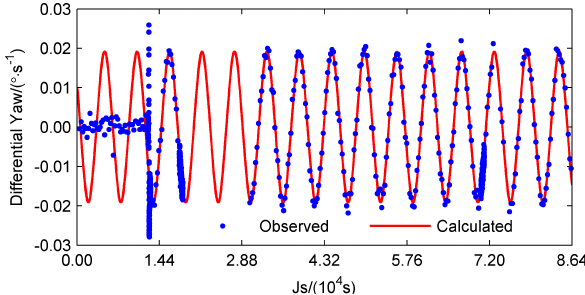
Figure 11. Simulations of the yaw angle with orbital elements